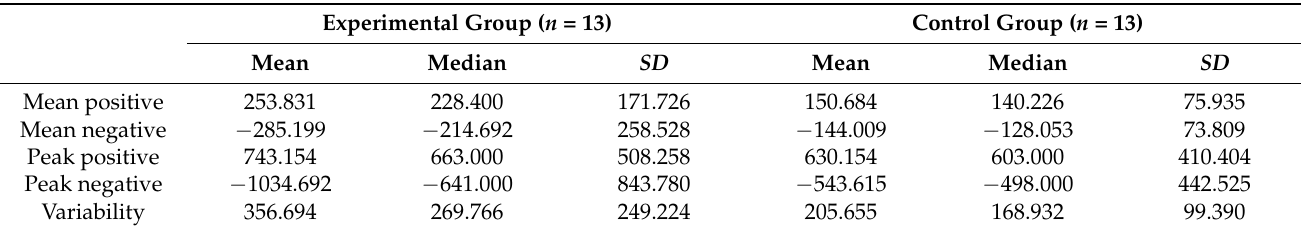
Table 4. Trial Level Bias Score: Mean positive, mean negative, peak positive, peak negative and variability: Mean RT (ms), median, and SD